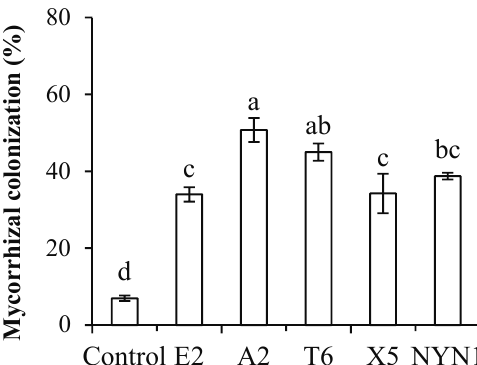
Figure 1. Colonization of AMF isolates. Different letters indicate significant differences ( F = 27.58; p ≤ 0.05) among the different treatments after ANOVA and LSD tests. Bars are the mean ± SE ( n = 4).